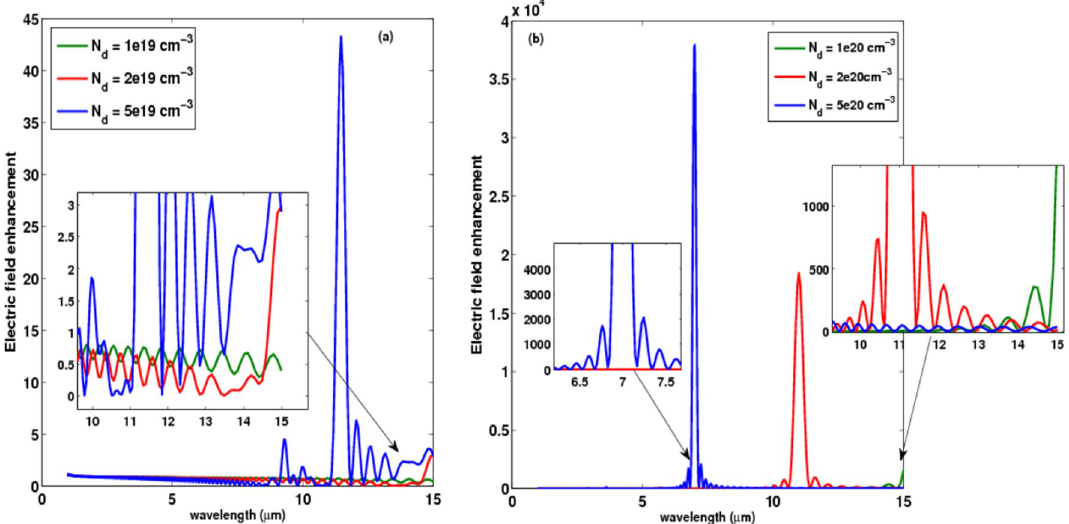
Figure 5. Electric field enhancement at the center of the gap ( x = 0, y = 0) versus wavelength for different doping concentrations. The polarization of the incident plane wave is along the antenna ( x-